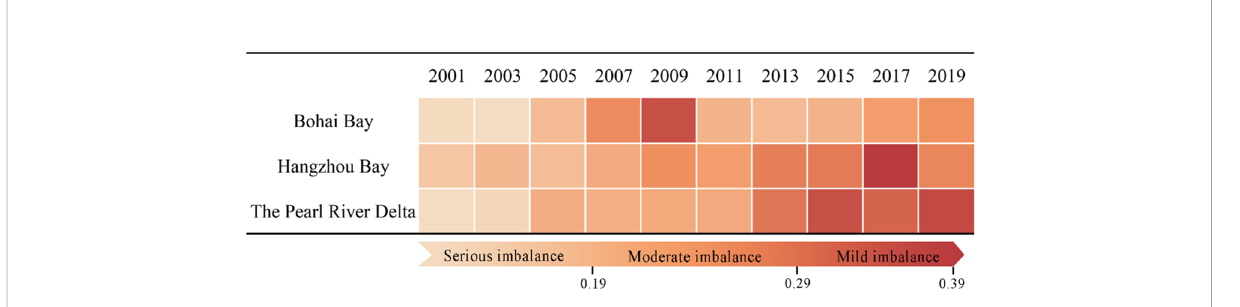
FIGURE 6 Coupling coordinated level of the three bay areas during 2001 – 2019. The coupling coordination level in the three bay areas is overall imbalance, but they show a trend of fl uctuation improvement. The coordinated development of PRD and HZB in south China is better than that of BHB in north